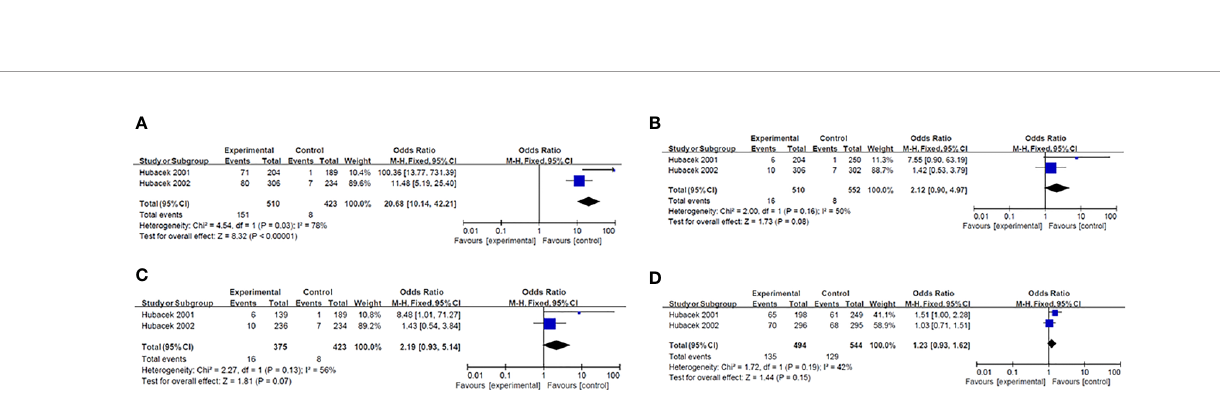
FIGURE 1 | Forest plot in rs2232618. (A) Dominant model (TT+TC vs CC). (B) heterozygote model (TC vs CC). (C) homozygotes models (TT vs CC). (D) recessive models (TT vs TC + CC).